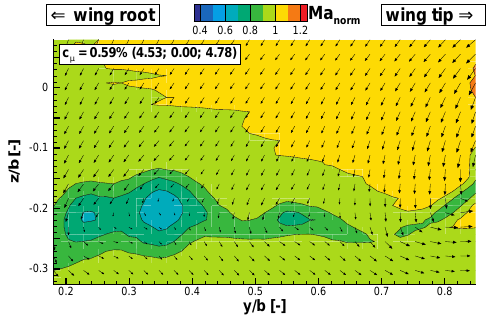
Figure 22. Wake flow at ( α max , base + 0.7 ◦ ) for the controlled